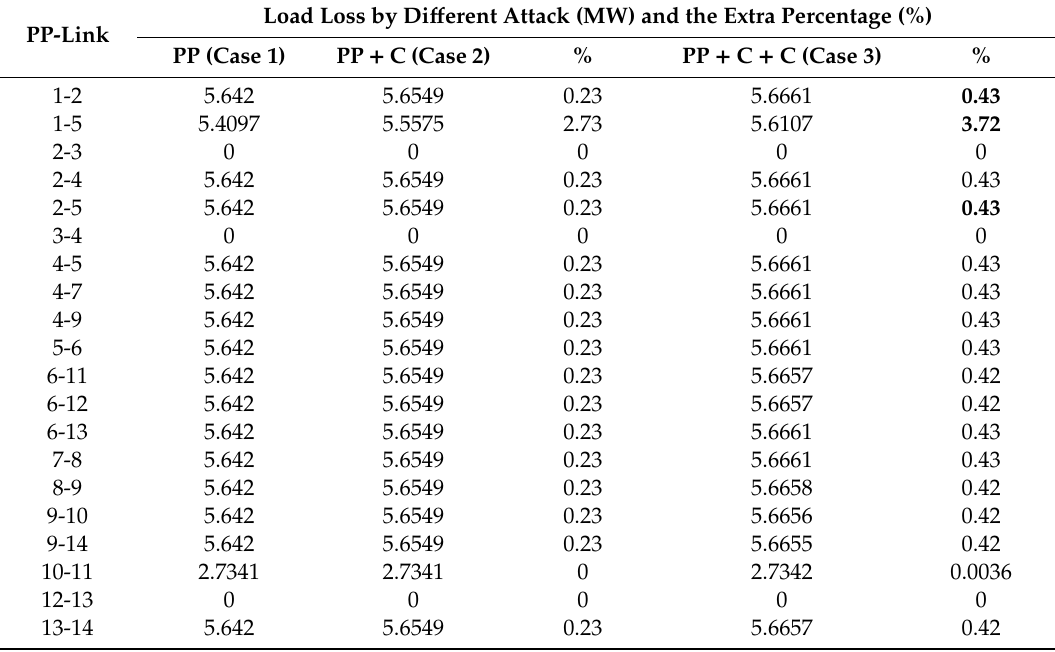
Table 3. Expected load loss after distributions of defensive